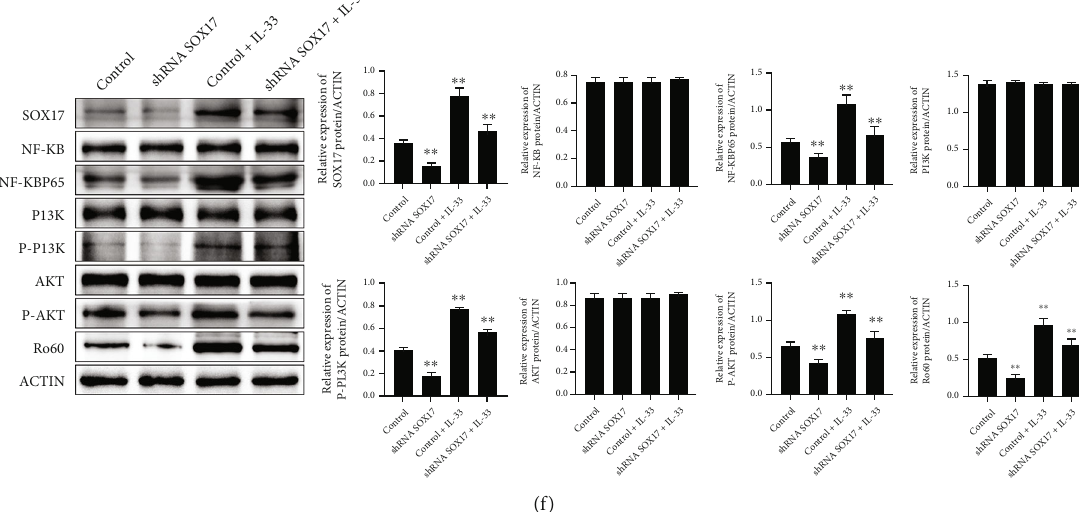
Figure 6: SOX17 is pivotal in IL-33 ’ s e ff ect on KCs. (a) Detection of SOX17, NF- κ B, PI3K, AKT, and Ro60 mRNA expression in KCs following IL-33 treatment by qRT-PCR. (b) Western blot determination of SOX17, NF- κ B, NF-KBP65, PI3K, p-PI3K AKT, p-AKT, and Ro60 expression in KCs following IL-33 irradiation. (c) qRT-PCR determination of SOX17 expression in KCs after SOx17 siRNA transfection. (d) Western blot determination of SOX17 expression in KCs after SOX17 siRNA transfection. (e) qRT-PCR determination of SOX17, CCL2, and ICAM-1 mRNA expression in KCs following IL-33 stimulation. (f) Western blot determination of SOX17, NF- κ B, NF-KBP65, PI3K, p-PI3K AKT, p-AKT, and Ro60 expression in KCs following SOX17 siRNA transfection and IL-33 treatment.